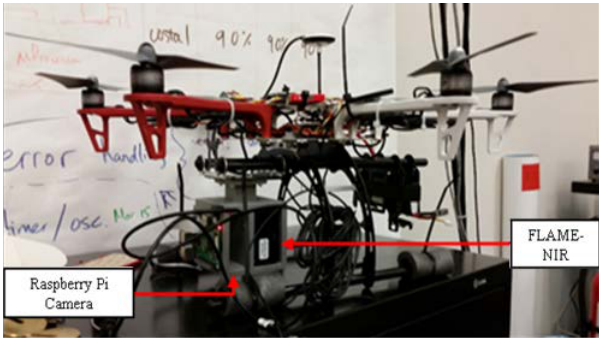
Figure 1. UAV system consisting of DJI Flamewheel F550 with mounted FLAME-NIR spectrometer and Raspberry Pi board and camera module payload.